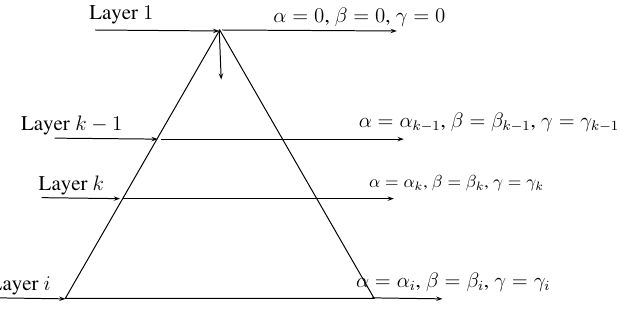
Figure 2. The pyramid model of an